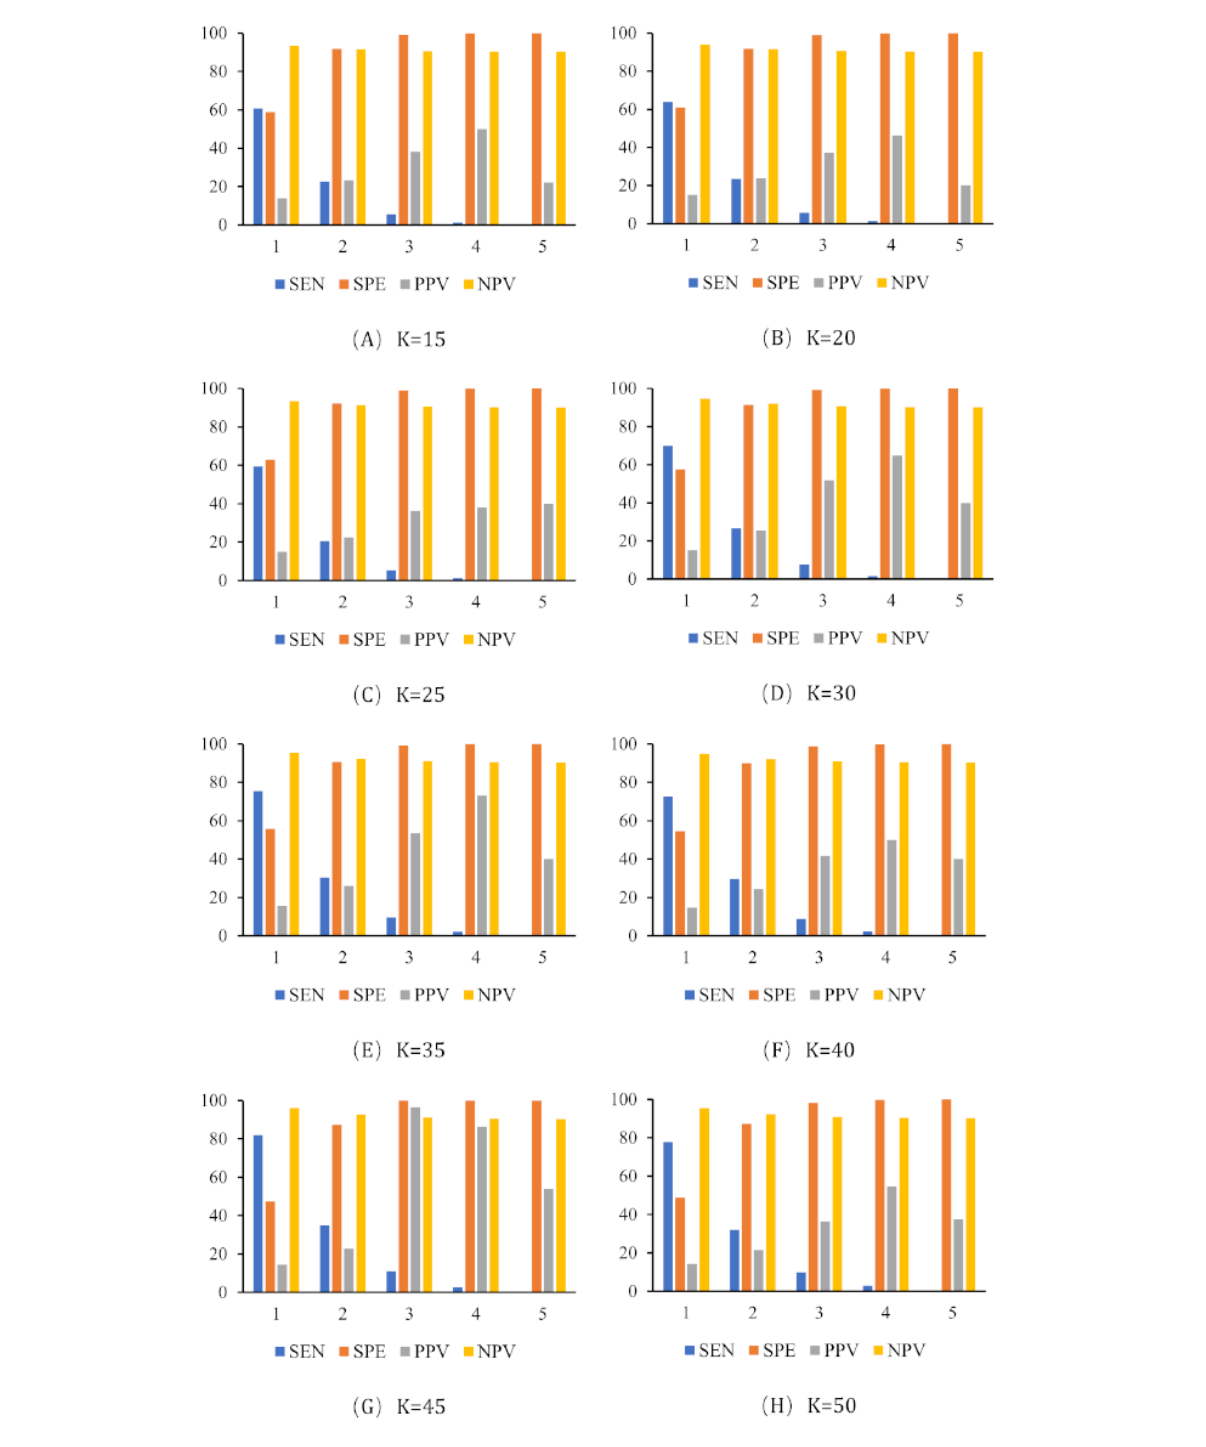
Figure 3. Summary of the performance of multiview latent Dirichlet allocation model with TM detection methods under different thresholds. Horizontal axis: thresholds of TM methods (from 1 to 5). Vertical axis: percentage of SEN, SPE, PPV, and NPV. K: number of topics; NPV: negative-predictive value; PPV: positive-predictive value; SEN: sensitivity; SPE: specificity; TM: topic